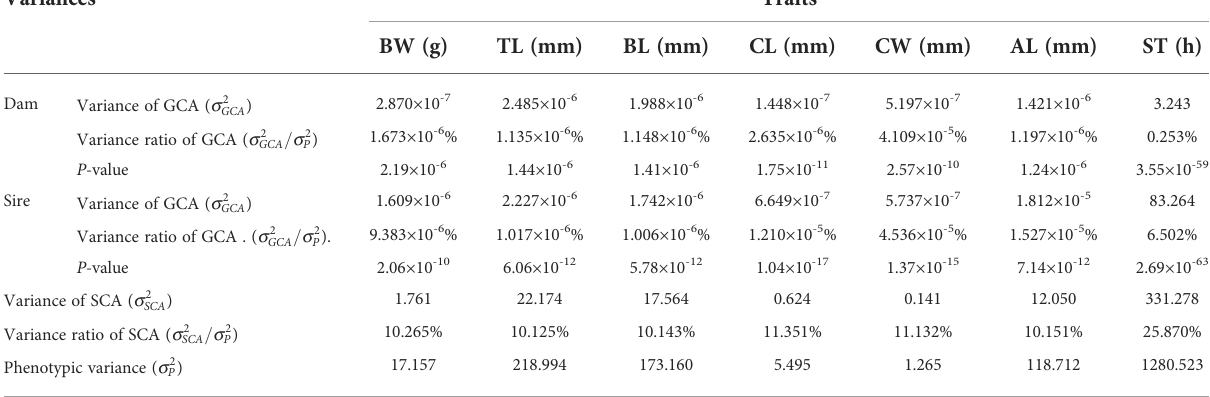
TABLE 4 Variance components of combining ability for growth and multiple stress tolerance traits in L. vannamei. .